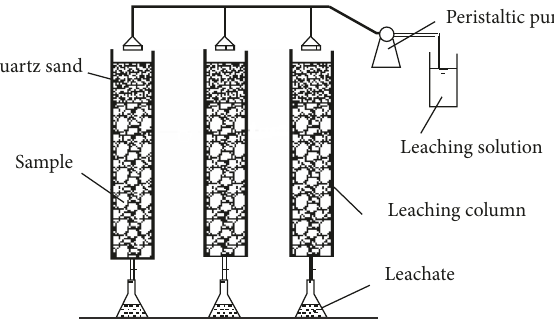
Figure 2: Schematic diagram of the leaching